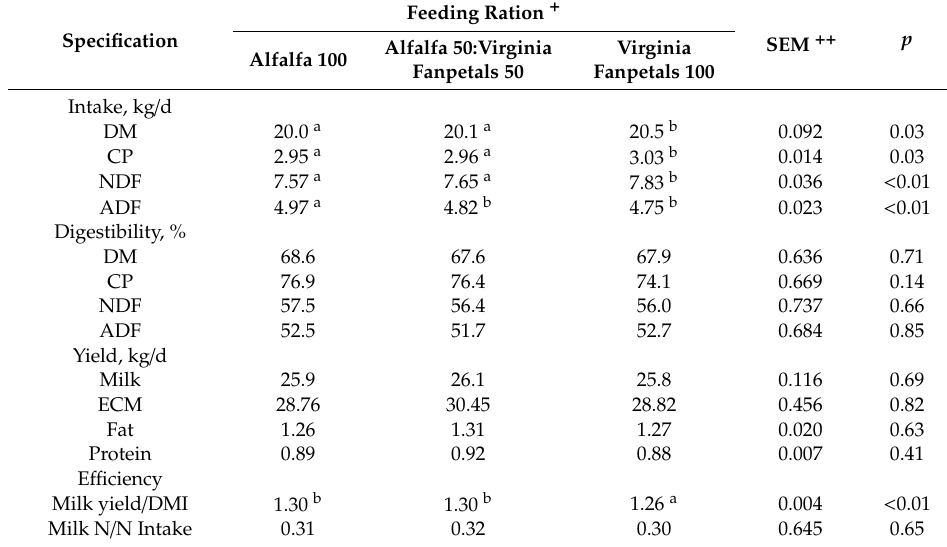
Table 5. Intake, digestibility DM and nutrients, milk yield and composition, and e ffi ciencies of DM and N used for milk production of lactating dairy cows fed di ff erent